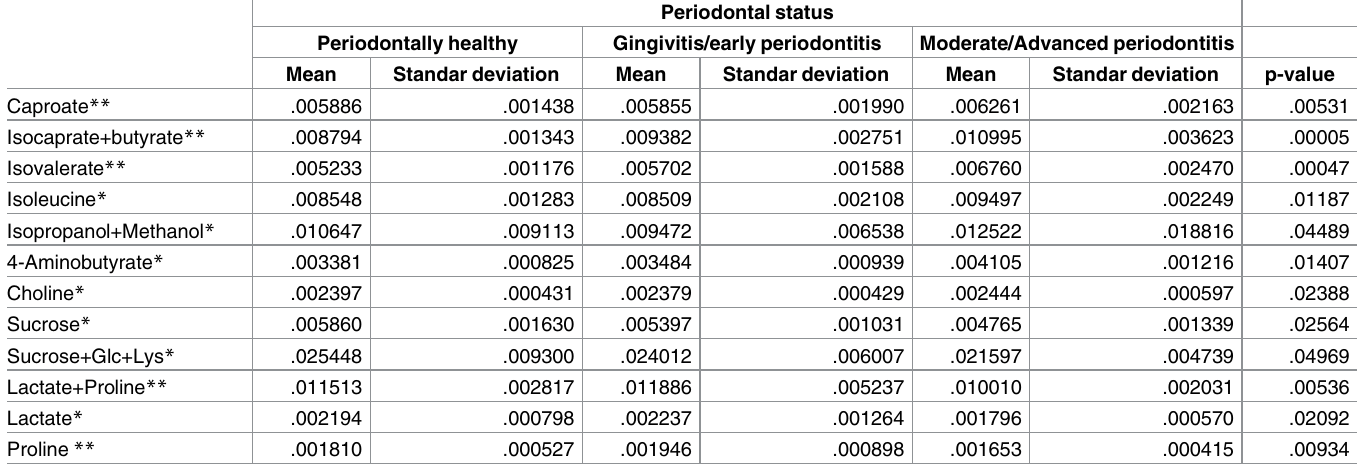
Table 4. Metabolites identified and compared attending the periodontal satatus. * p < 0.05 and ** p <